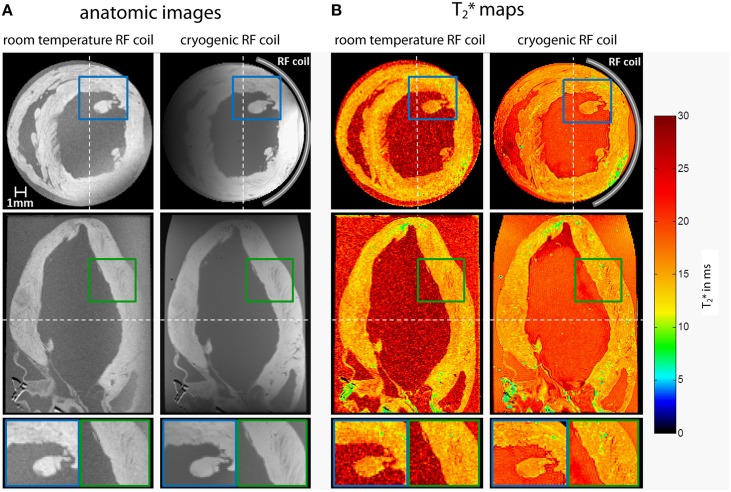
Axial (top) and coronal (center) views of high resolution T2* weighted 3D MR microscopy images (A) and corresponding T2* maps (B) of the fixed ex vivo rat heart acquired using a room temperature volume RF resonator and a cryogenic surface RF probe at 9.4 T [3D multi echo gradient echo technique, TR = 19 ms, TE = 2.14–13.54 ms, TE spacing 2.85 ms, spatial resolution = (94 × 94 × 94) μm3, FOV = (20 × 15 × 15) mm2, acquisition time 12.7 h]. Bottom: Detail views of areas marked by colored rectangles. Dashed white lines mark the position of the slices. Data from Huelnhagen et al. (2014); Peper et al. (2015).